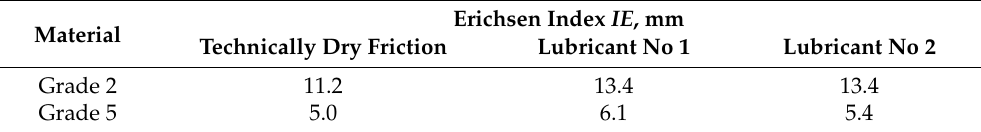
Figure 6. View of cups after the Erichsen cupping test. Table 4. Results of the Erichsen cupping test.